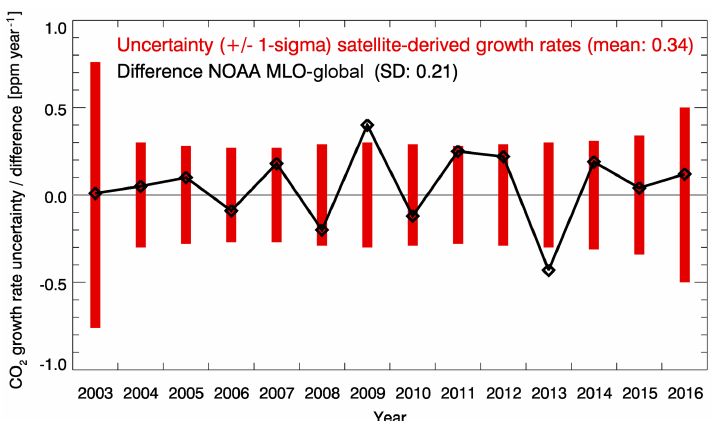
Figure A2. Comparison of the 1 σ uncertainty range of the satellite-derived growth rates (red bars) with the difference between two annual mean growth rate time series obtained from NOAA, namely the time series from Mauna Loa (MLO), Hawaii, and the global time series obtained from globally averaged marine surface data (black line and